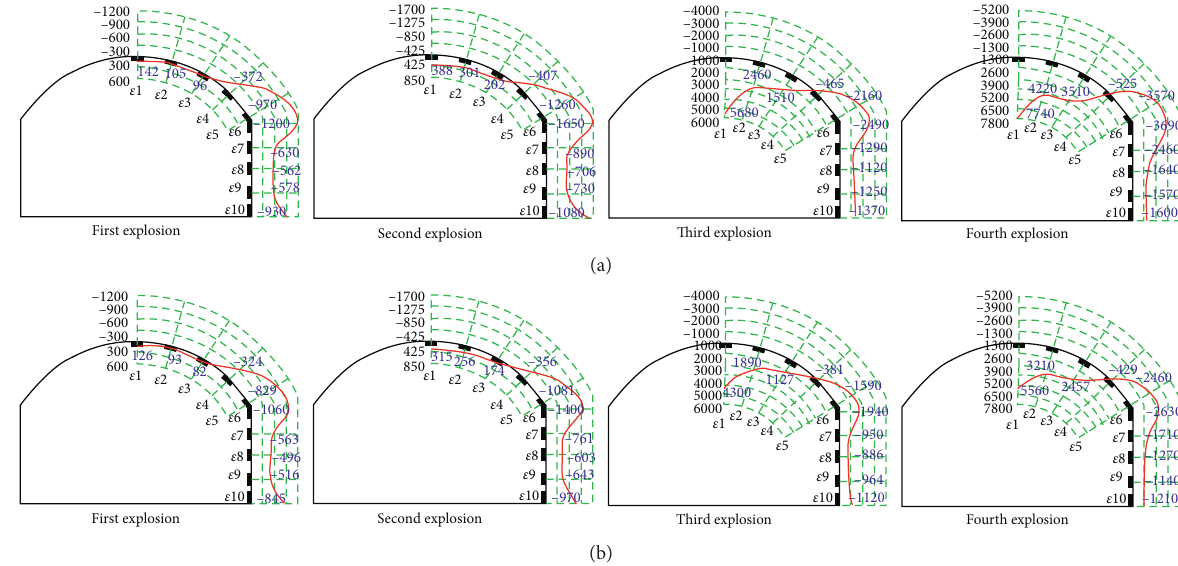
Figure 10: Distribution of peak circumferential strain around the cavern wall. (a) Unanchored. (b) Anchored (unit: 10 − 6